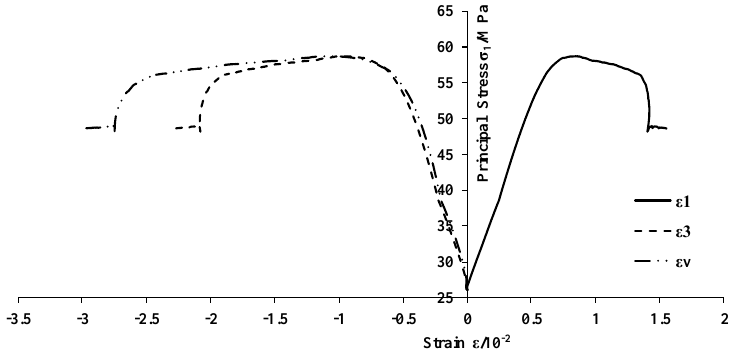
Figure 7. Mining-induced stress-strain curve of a coal sample (N-2-1).